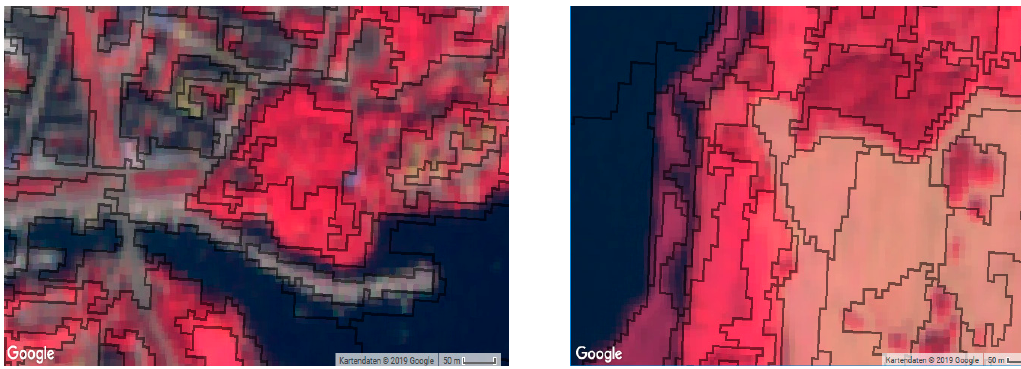
Figure 1. Stockholm (left) and Beijing (right) study site extents.